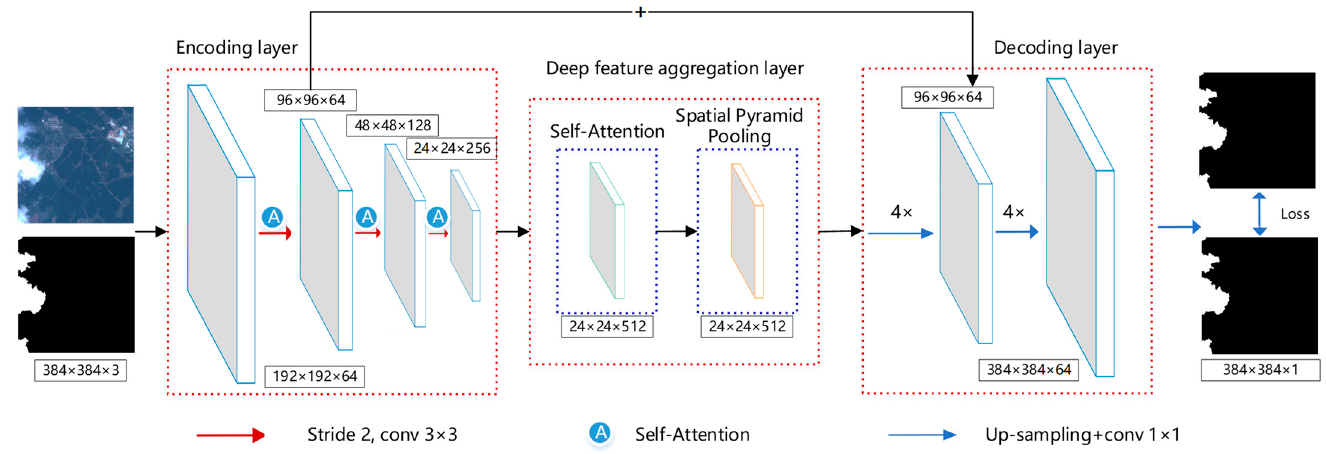
Figure 2. Proposed cloud detection module.